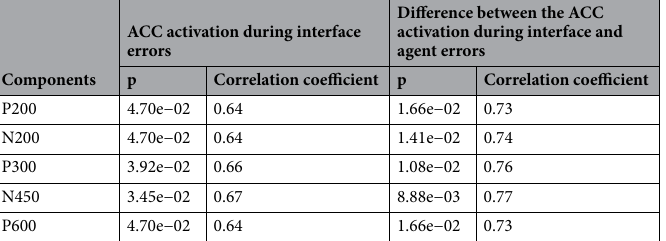
Table 2. The p-values and the Spearman correlation coefficients between the AAACC during the components and the neuroticism scores of the Big Five Questionnaire.